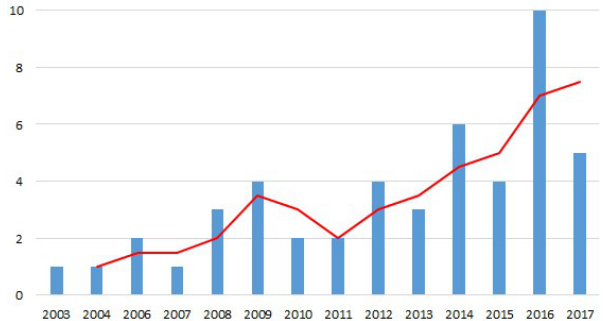
Fig. 1. Number of papers per year, found in the ACM Digital Library when searching for “Actor-Network Theory”. Red line is the moving average with period 2. Data retrieved in January 11,